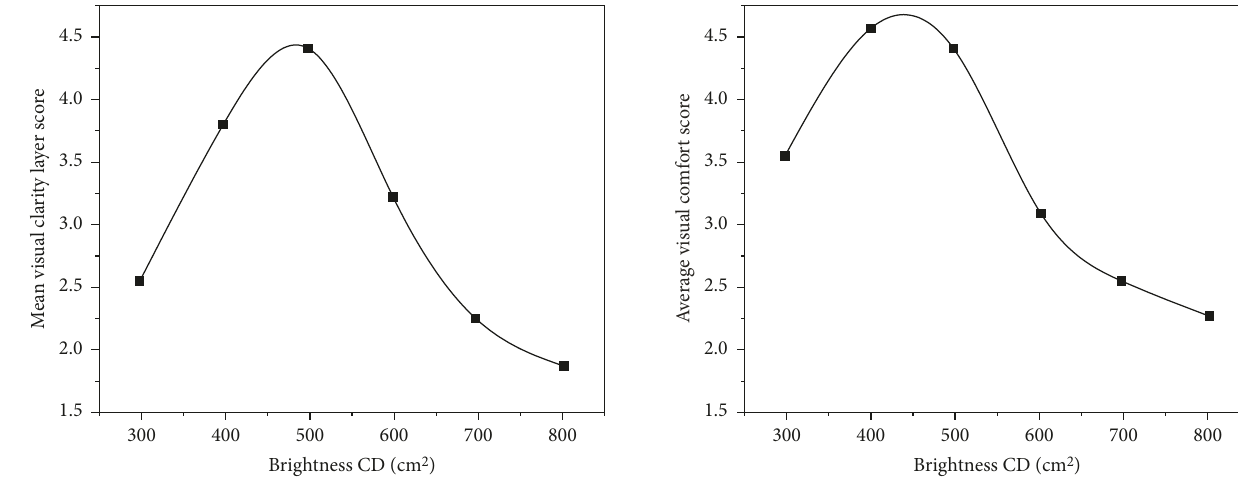
Figure 9: Line chart of brightness and visual clarity. Figure 10: Broken line diagram of brightness and visual